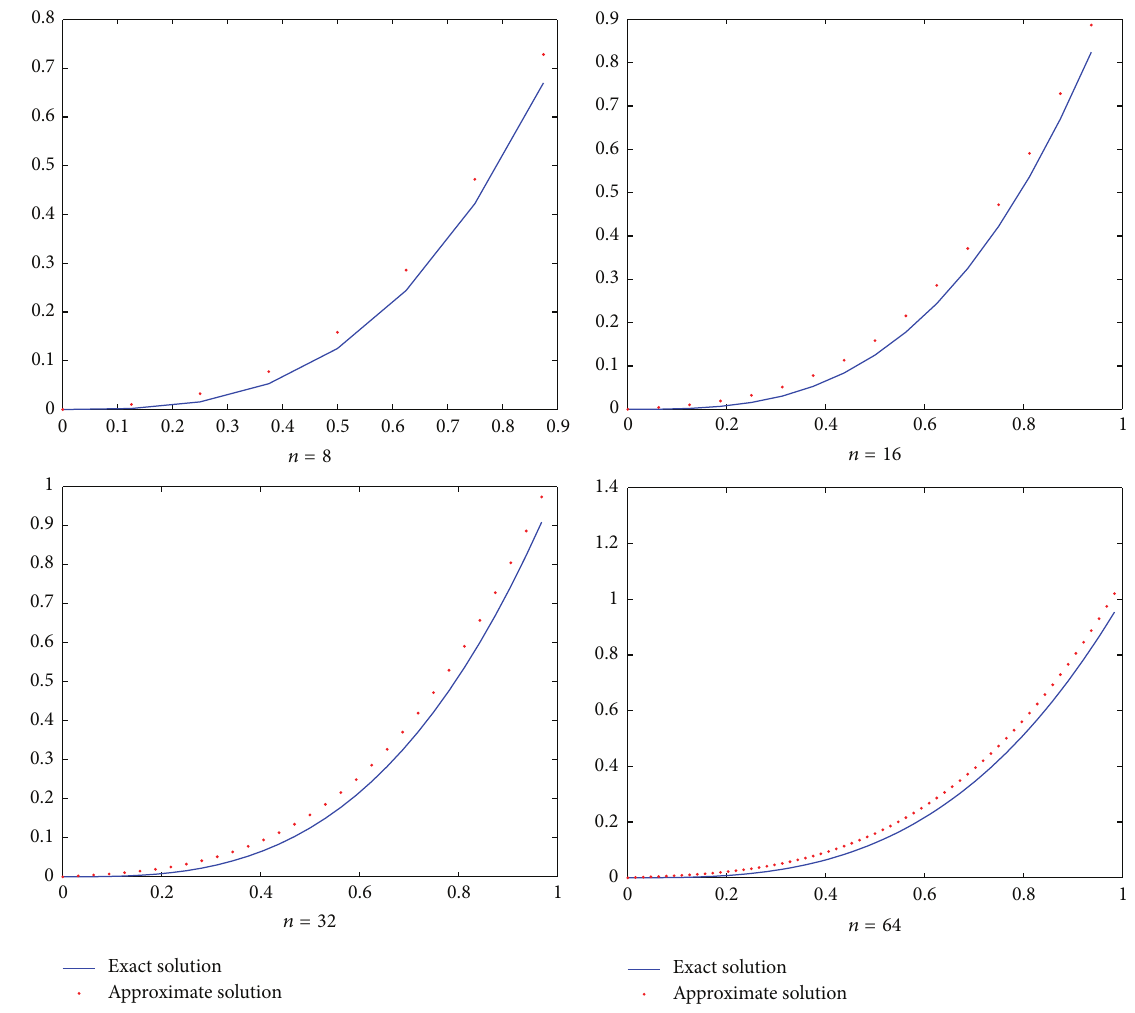
Figure 1: Curves of the exact and approximate solutions for 𝑛 = {8,16, 32, 64}